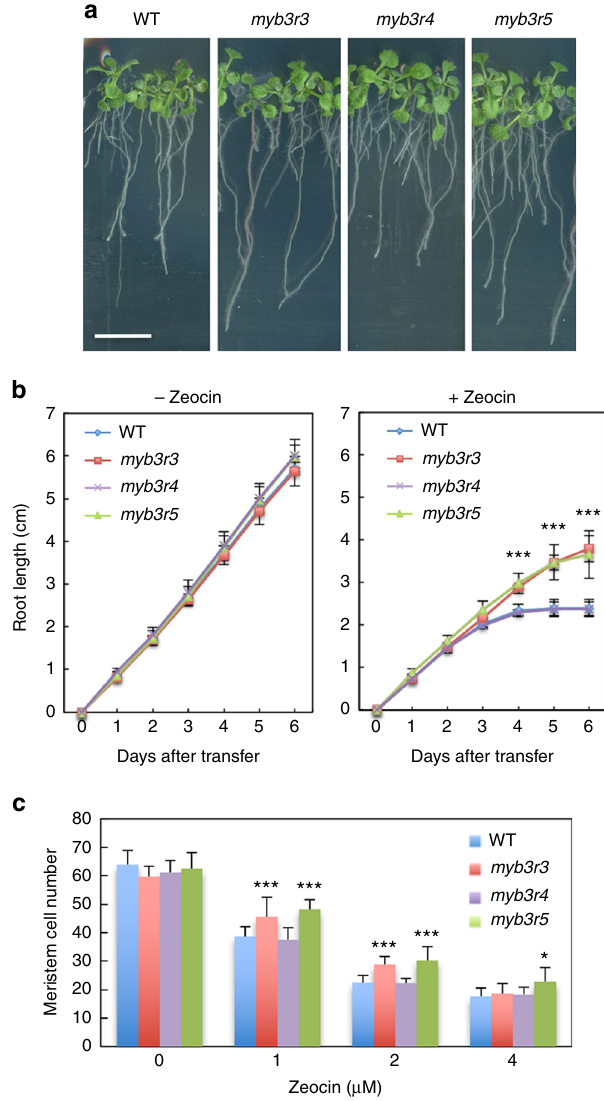
Fig. 1 Zeocin response of myb3r mutants. a Seedlings of WT and myb3r mutants. Five-day-old seedlings were transferred to medium with 2 µ M zeocin and grown for 6 days. Scale bar , 1 cm. b Root growth of WT and myb3r mutants. Five-day-old seedlings were transferred to medium with or without 2 µ M zeocin, and root length was measured for 6 days. c Meristem size of WT and myb3r mutants. Five-day-old seedlings were transferred to medium with different concentrations of zeocin, and cortex cell number between the quiescent centre and the fi rst elongated cell was counted after 24 h. Data are presented as mean ± SD (n = 30). Signi fi cant differences from WT were determined by Student ’ s t -test: * P < 0.05; *** P <